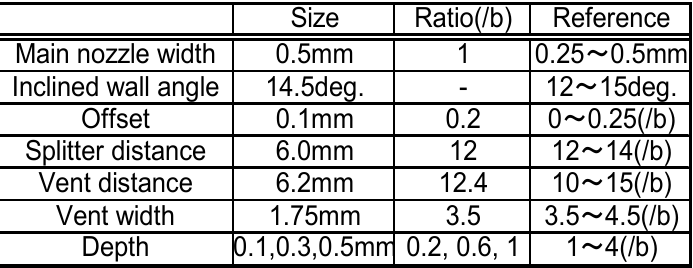
Construction of tested fluidic device Design parameter of tested